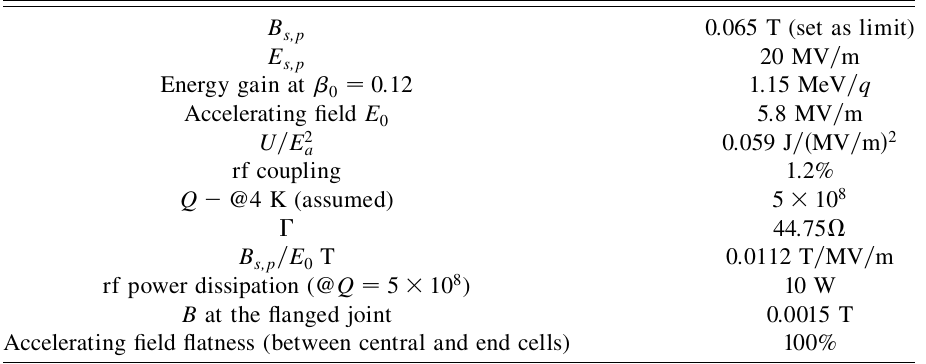
TABLE II. Ladder resonator rf